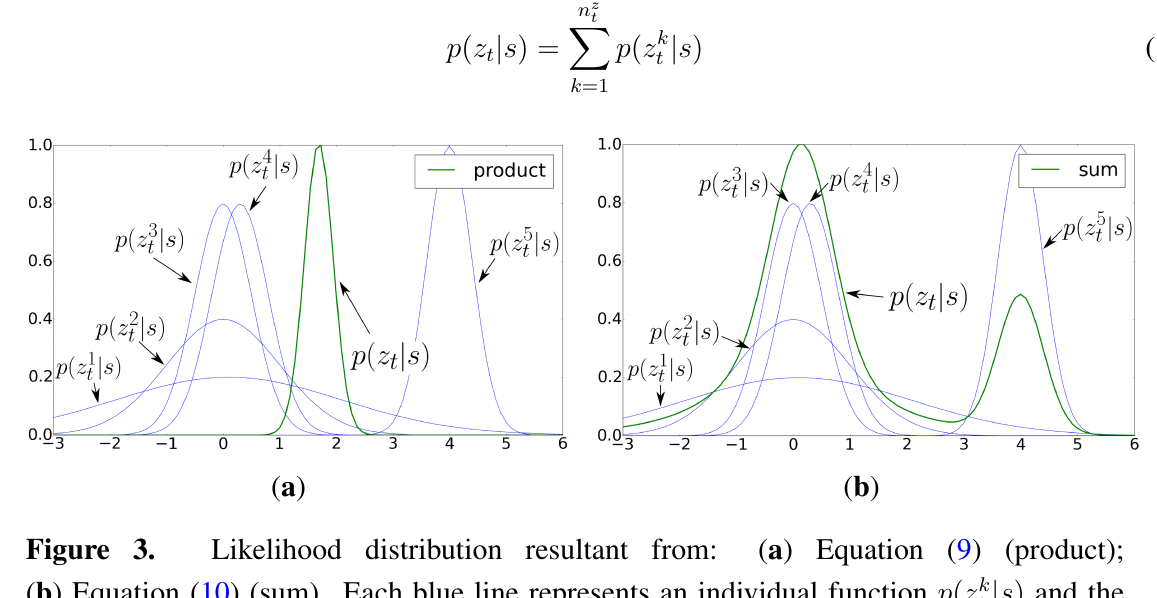
Figure 3. Likelihood distribution resultant from: ( a ) Equation (9) (product); ( b ) Equation (10) (sum). Each blue line represents an individual function p ( z k green line the fusion of these functions using Equation (9) or (10),